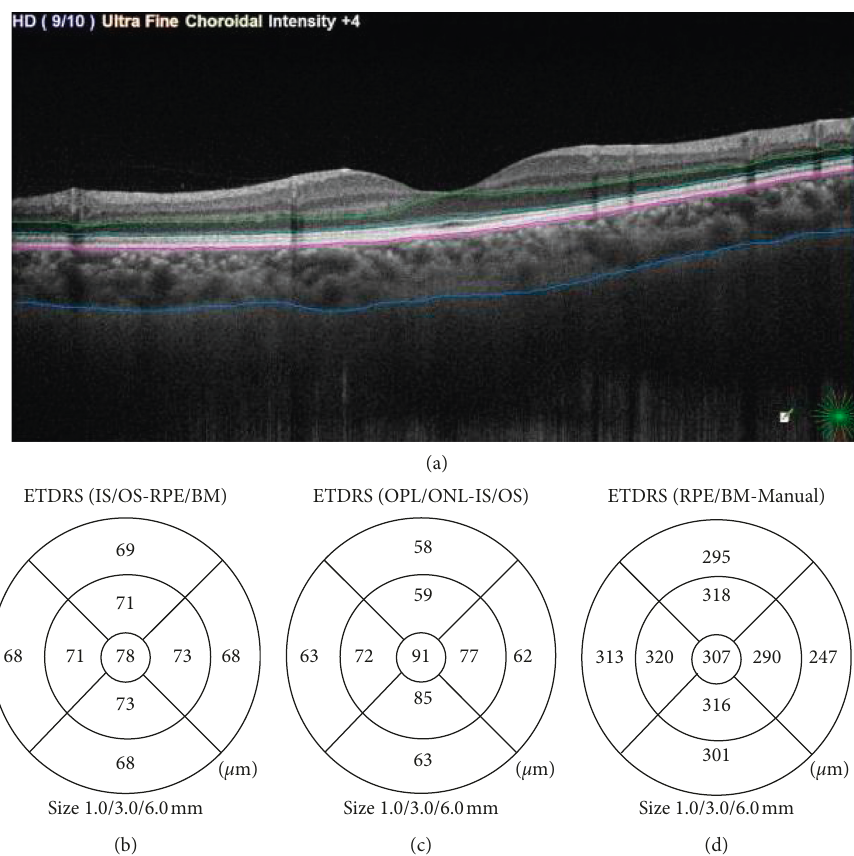
Figure 1: (a) OCT radial scan. ETDRS map: (b) retinal pigment epithelium and photoreceptor outer segment (RPE-OS) layer thickness (extending from the inner segment/outer segment (IS/OS) layer to the outer surface of RPE); (c) the outer nuclear layer and photoreceptor inner segment (ONL-IS) thickness (measured from the interface between the outer plexiform layer (OPL) and the outer nuclear layer (ONL) extending to the IS/OS layer); (d) choroidal thickness (CT) measured from the outer surface of RPE to the manually drawn sclerochoroidal interface.